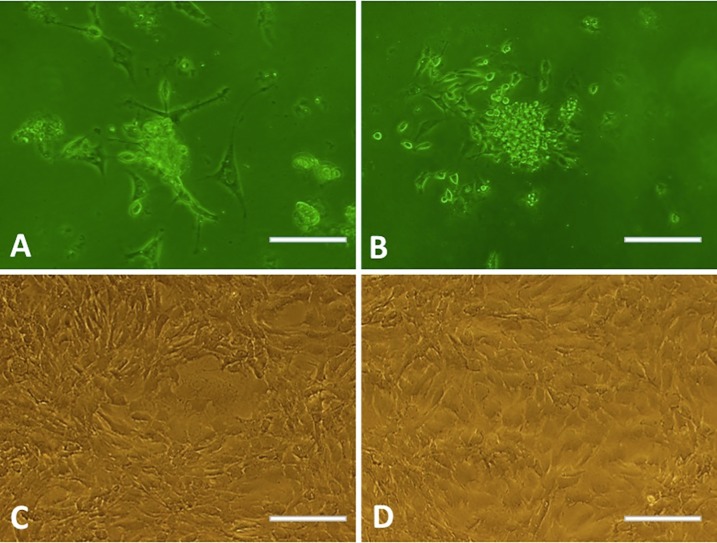
The clone and morphologic observation of TSCs by microscope.(A) P0 TSCs showed as large polygonal and star-shaped cells. (B) P1 TSCs showed as flat cells and slender fibroblast-like cells. (C) P3 TSCs showed a homogeneous population of fibroblast-like cells. (D) P3 TSCs arranged as pebbles at high rate of cell fusion. All scale bars = 100 μm.